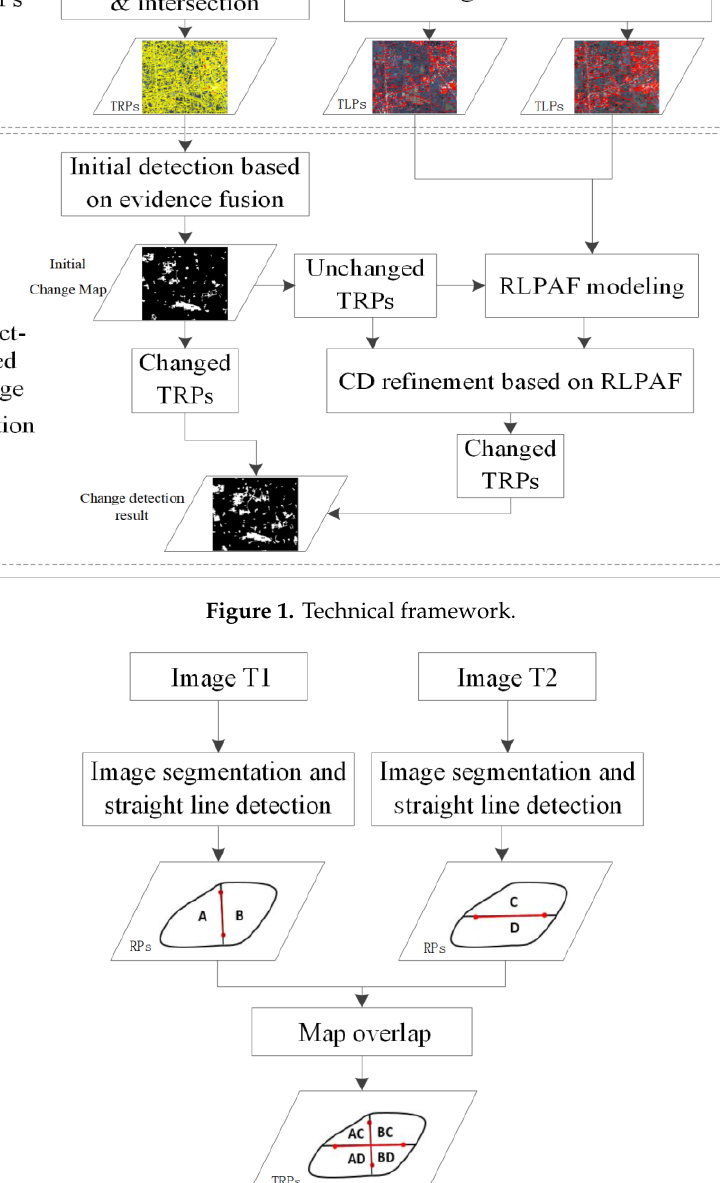
Figure 2. Creation of object primitives via image segmentation and map overlap.